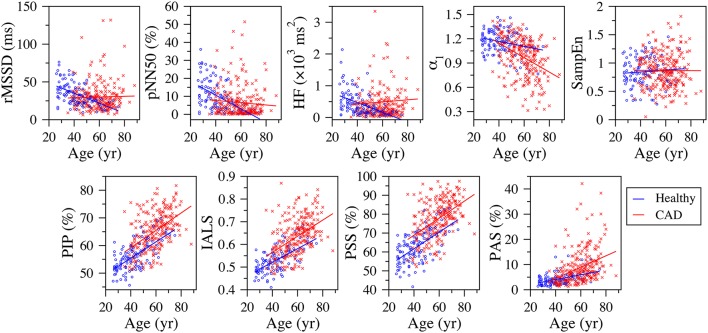
Scatter plots of the traditional heart rate variability (rMSSD, pNN50, and HF), nonlinear (α1 and SampEn) and fragmentation (PIP, IALS, PPS, and PAS) indices vs. the participants' age for the group of healthy subjects and patients with coronary artery disease (CAD), derived from the analysis of the full (~ 24-h) period. The solid lines are the linear regression lines. rMSSD, root mean square of the successive differences; pNN50, percentage of differences between successive NN intervals above 50 ms; HF, high frequency spectral power; α1, detrended fluctuation analysis short-term exponent; SampEn, sample entropy; PIP, percentage of inflection points; IALS, inverse of the average length of the acceleration/deceleration segments; PPS, percentage of NN intervals in short segments; PAS, percentage of NN intervals in alternation segments.